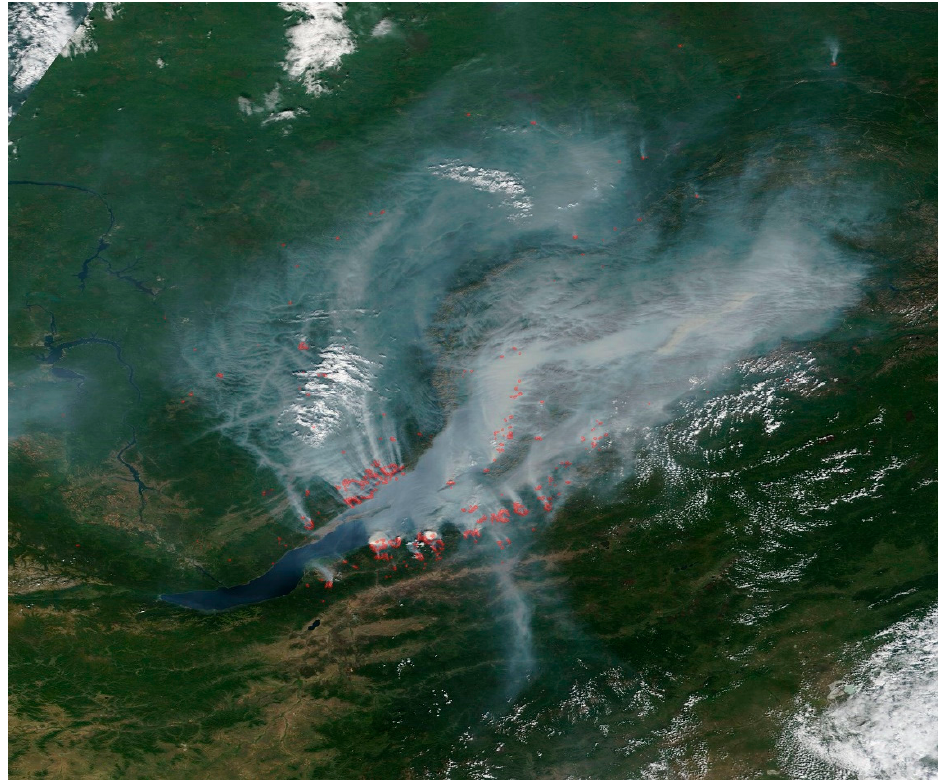
Figure 15. The image of fires and thermal anomalies (red) created by the Terra and Aqua satellite products (MOD14, MYD14, red color) on 22 August 2015, obtained using the World View of Global Imagery Browse Services (GIBS), is presented. The MODIS corrected reflectance imagery (true color: red = Band 1, green = Band 4, blue = Band 3) is presented as a background satellite image. The smoke from the wildfires are clearly visible.